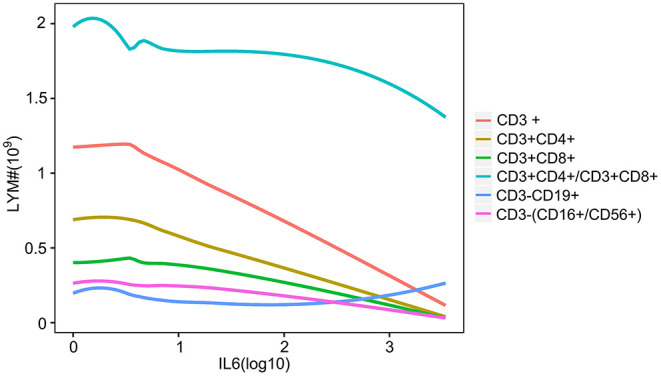
The relationship between IL-6 and lymphocyte subsets. The line plot indicates the dynamic changes in lymphocyte subsets with increase in the level of IL-6. Different colored lines show the different lymphocyte subsets. CD3+, CD3 positive lymphocyte; CD3+CD4+, CD3 and CD4 positive lymphocyte; CD3+CD8+, CD3 and CD8 positive lymphocyte; CD3+CD4+/CD3+CD8+, CD3, CD4, and CD8 positive lymphocyte; CD3-CD19+, CD3 negative and CD19 positive lymphocyte; CD3-(CD16+/CD56+), CD3 negative, CD16, and CD56 positive lymphocyte.